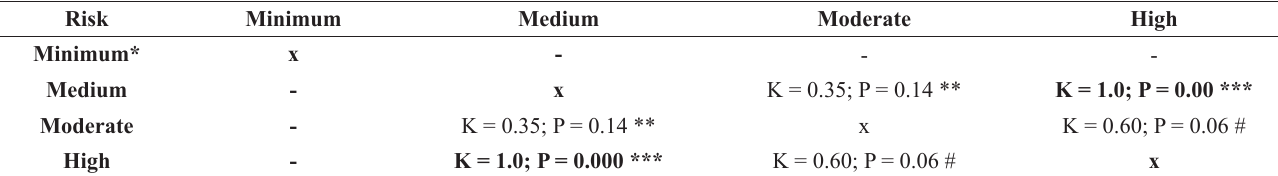
Table 8 - Kappa Index comparative table among the DMA injury risk